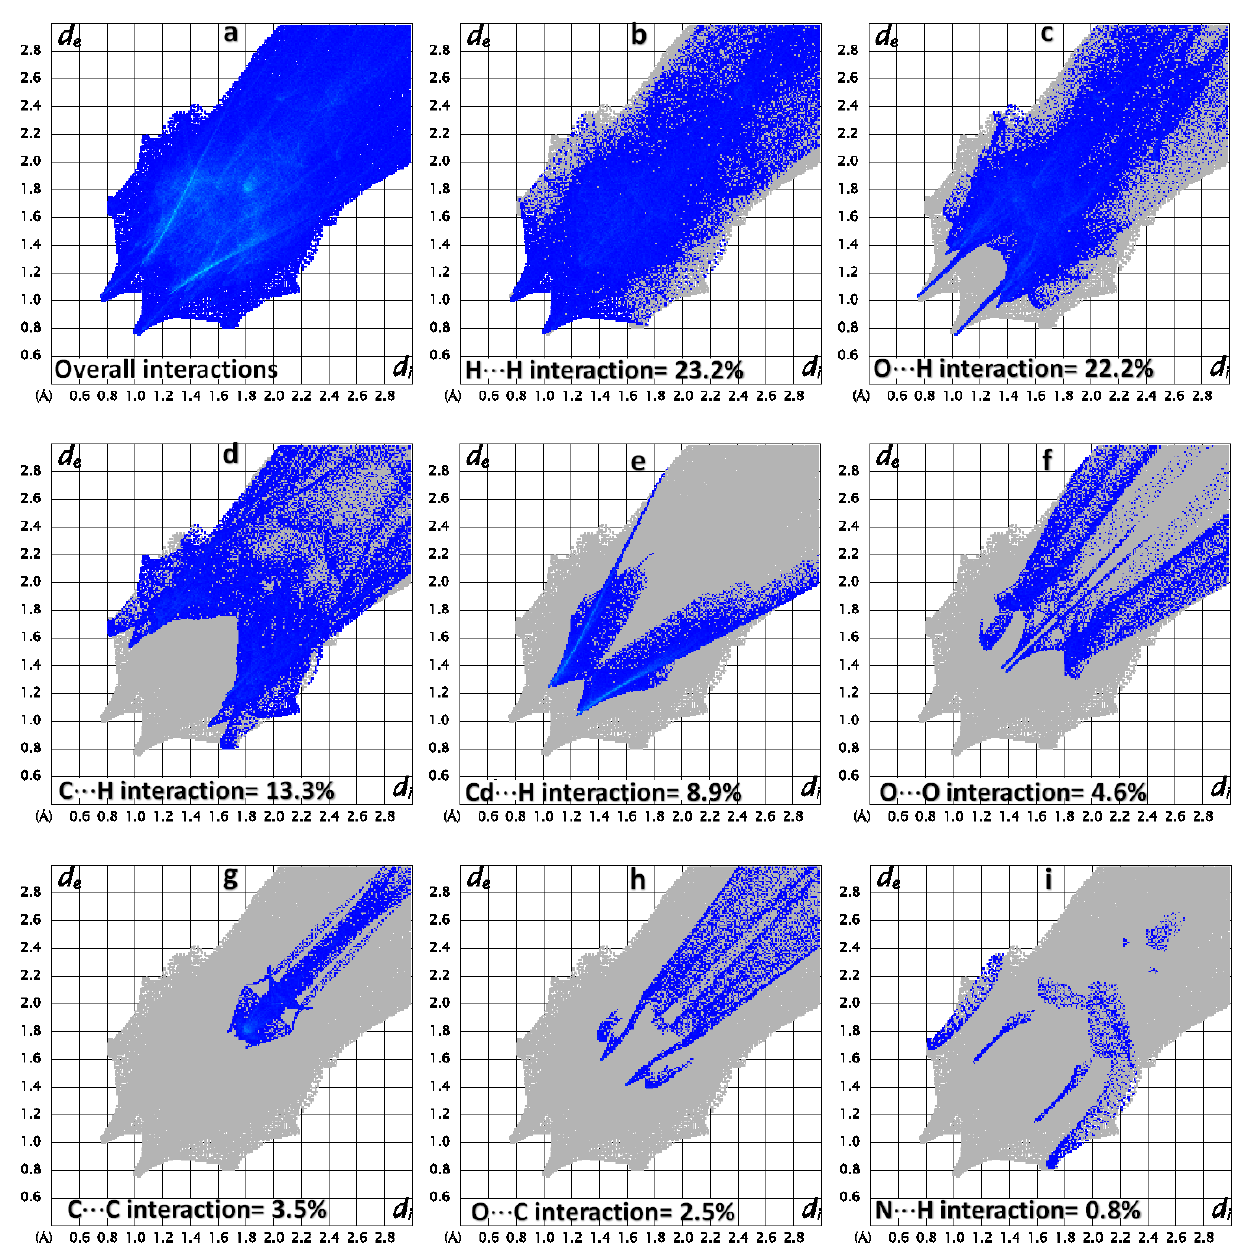
Figure 7. 2D fingerprint plots of CdMOF, for ( a ) Overall interactions, and ( b – i ) individual interatomic contacts with percentage contribution in the crystal packing greater than 0.7%.